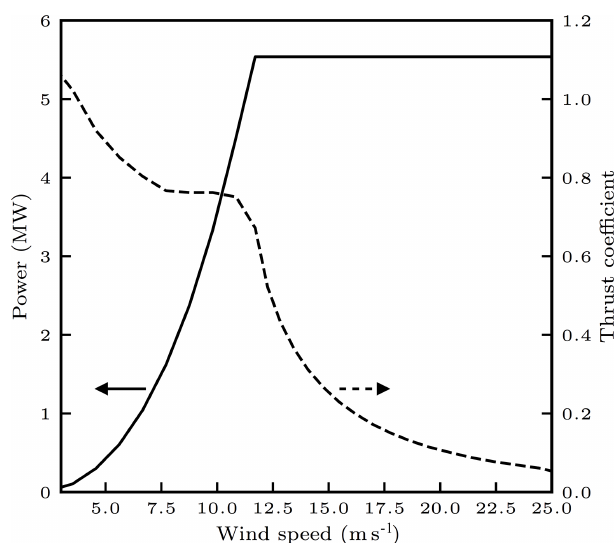
Figure 1. Power (solid line) and thrust coefficient (dashed line) as functions of wind speed for the NREL 5MW reference turbine (Jonkman et al., 2009). Arrows point from the curves to the corre- sponding vertical